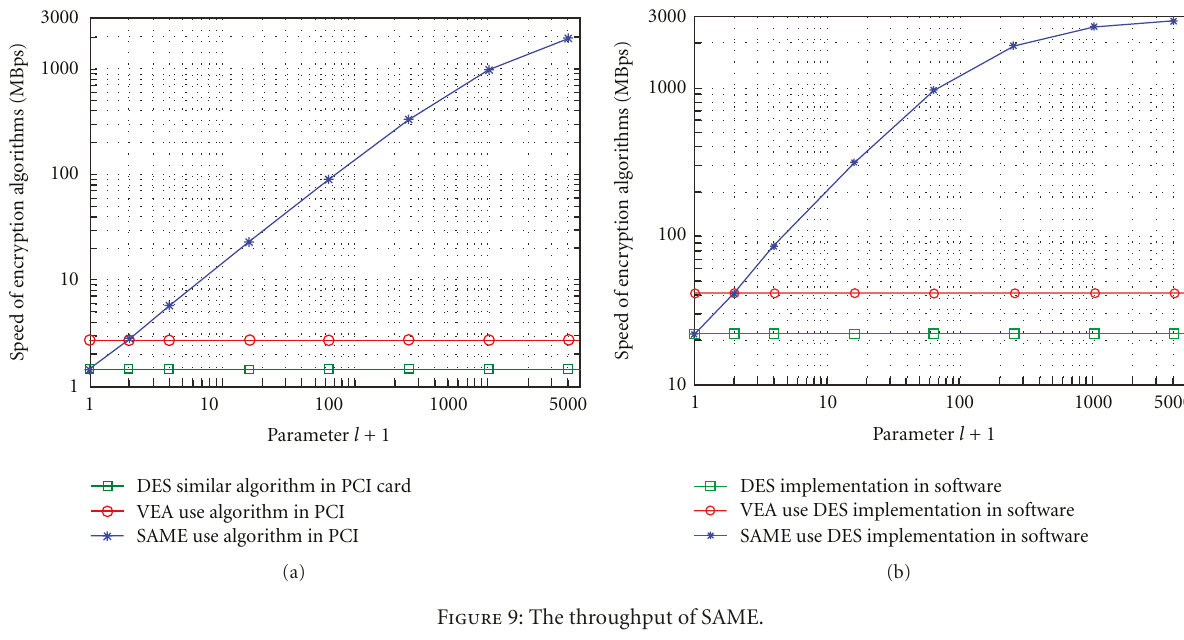
Figure 9: The throughput of